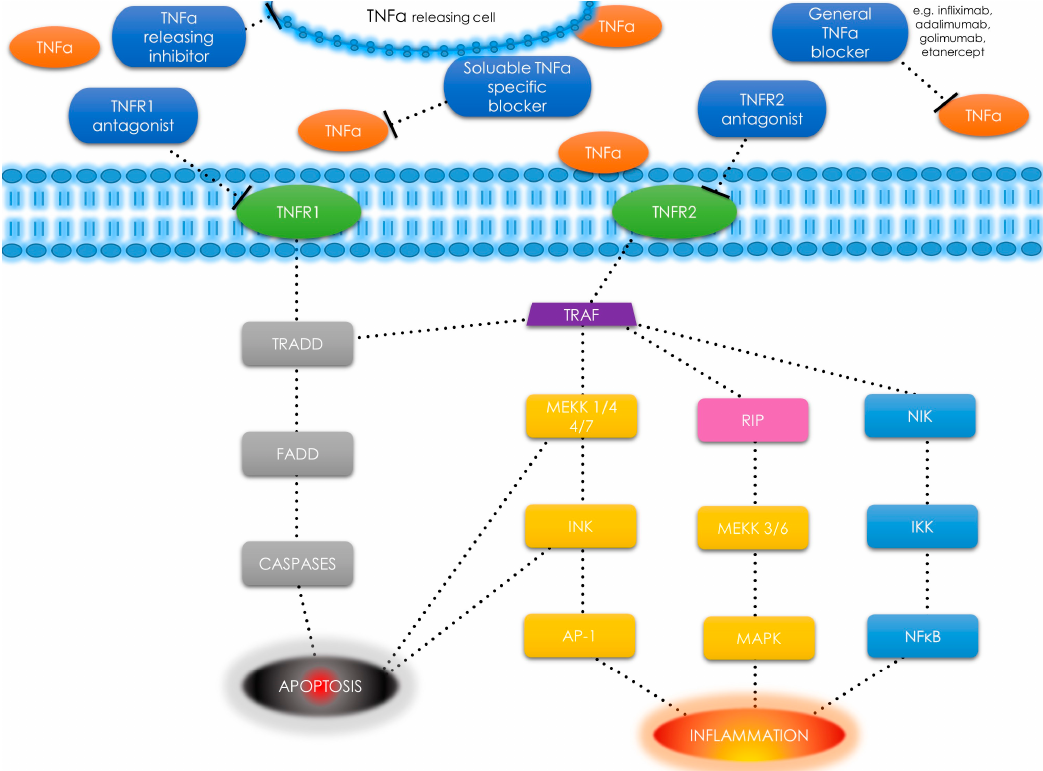
Figure 2. TNF- α receptors, pathways and different types of signals—schematic diagram. TNF- α has an ability to induce apoptosis, cell survival or inflammation depending on selected